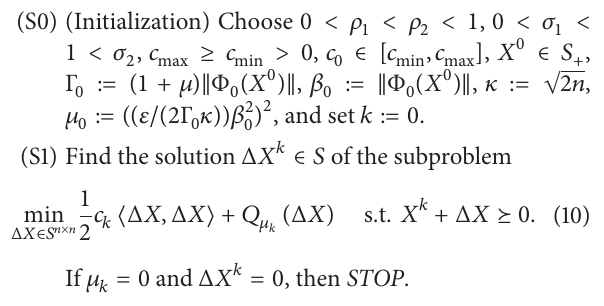
Algorithm 1 (continuous trust-region-type